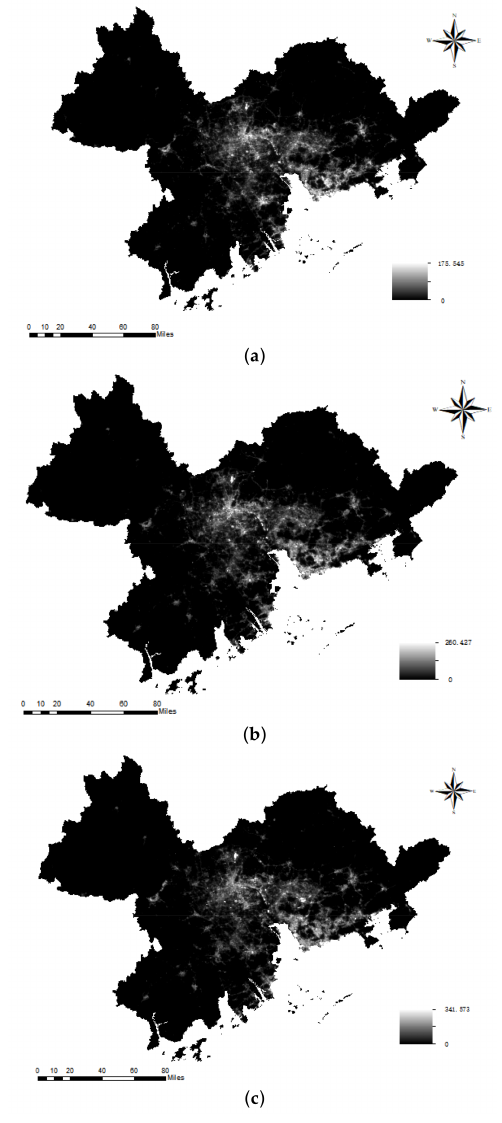
Figure 2. NPP-VIIRS NTL remote sensing images of the PRD. ( a ) 2013, ( b ) 2016, ( c ) 2019. Data Source: The National Oceanic and Atmospheric Administration (NOAA)